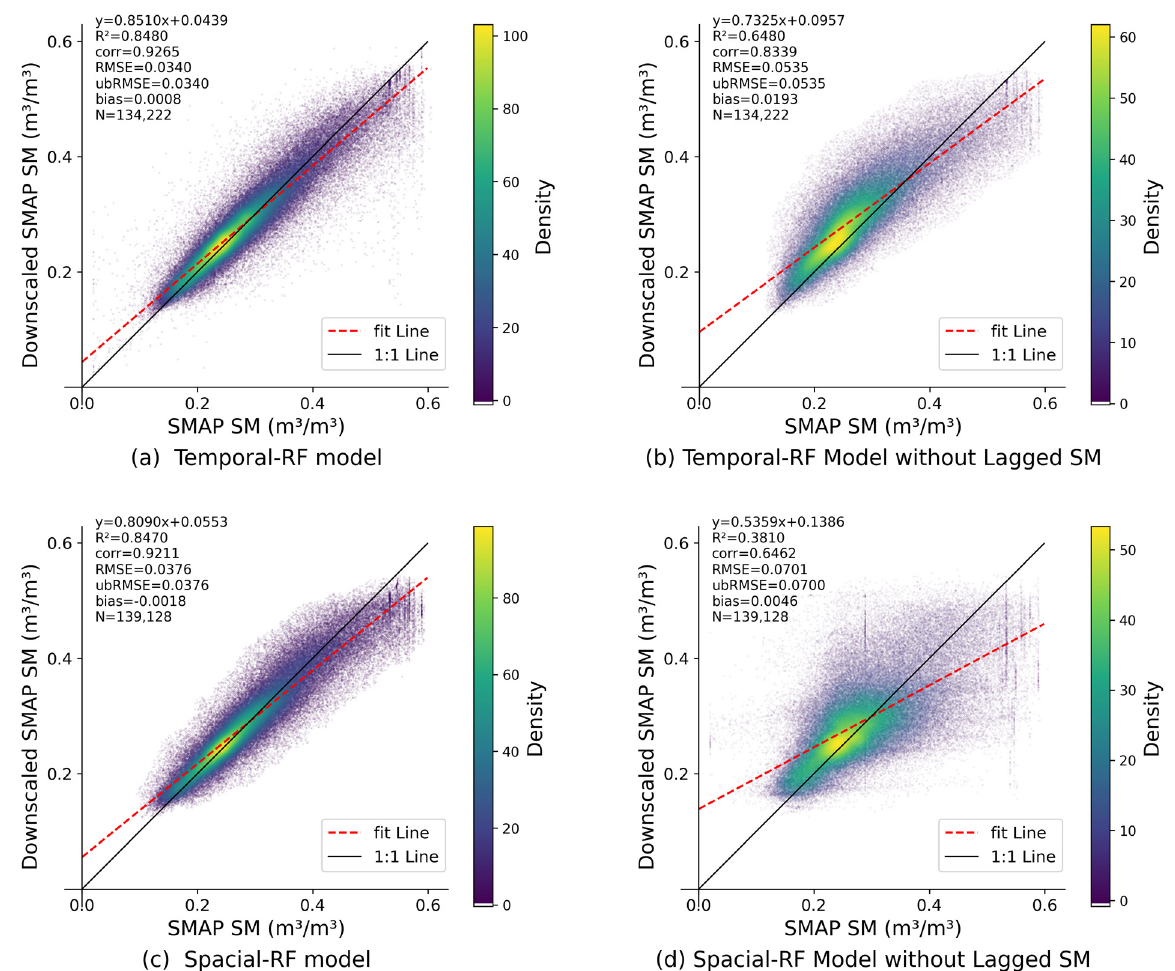
Figure 4. Scatters-plot of the test set of different models.